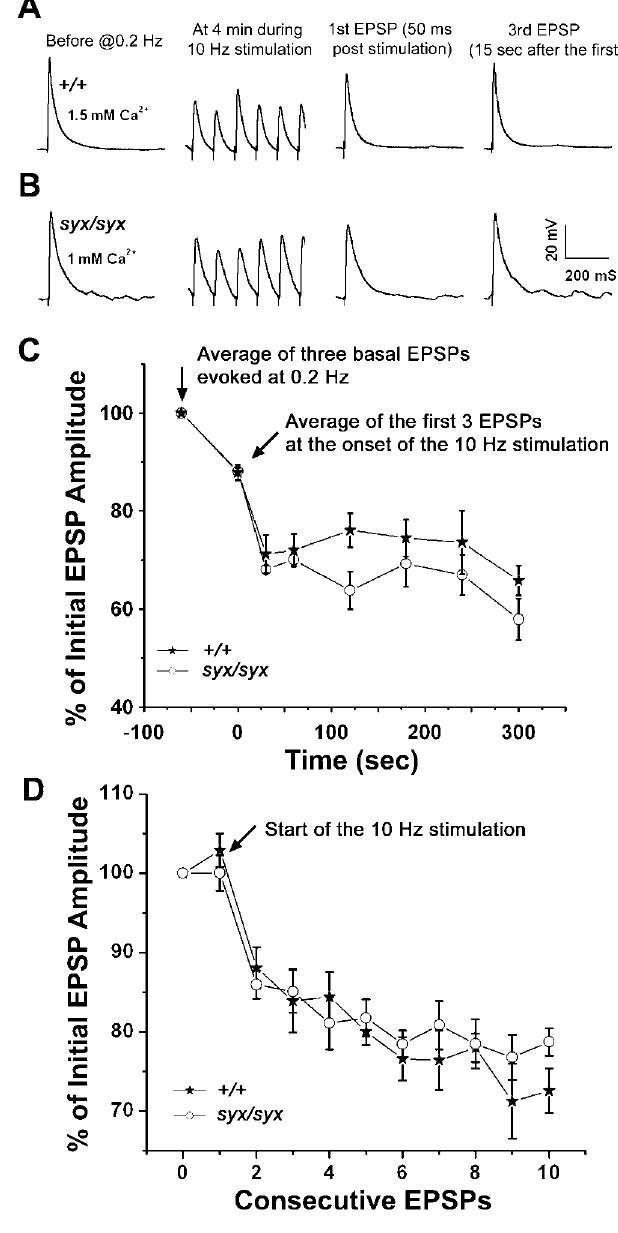
Figure 8. The T254I Mutation in the Syntaxin 1A Does Not Affect Synaptic Vesicle Recycling (A and B) Representative traces of EPSPs from the wild-type ( þ / þ [A]) and the syx 3–69 mutant larvae ( syx/syx [B]) before, 4 min during, and 50 ms after a 5-min repetitive stimulation at 10 Hz. The nerve is stimulated at 0.2 Hz prior to and after the repetitive stimulation. Note that the extracellular [Ca 2 þ ] was adjusted to 1.5 mM in the wild type and 1 mM in the mutant so that their basal transmitter release is similar. (C) EPSP amplitudes decline after the onset of 10-Hz repetitive stimulation over a 5-min period. The average amplitude of three consecutive EPSPs is obtained at the onset of the 10-Hz stimulation (time zero), at 30 sec, and at every minute thereafter. These average values are then normalized to the basal EPSP amplitude evoked at 0.2 Hz prior to the repetitive stimulation. The steady-state level is reached when the rate of exocytosis equals that of vesicle recycling. The decline rate is essentially similarbetweenthetwo genotypes, suggesting thatthe syx 3–69 mutant does not differ significantly from the wild type in vesicle recycling. (D) The RRP of synaptic vesicles can be depleted within a few stimuli. This plot shows the relatively decline of the EPSP amplitude following the first ten stimuli at 10 Hz. The nearly identical decline rate